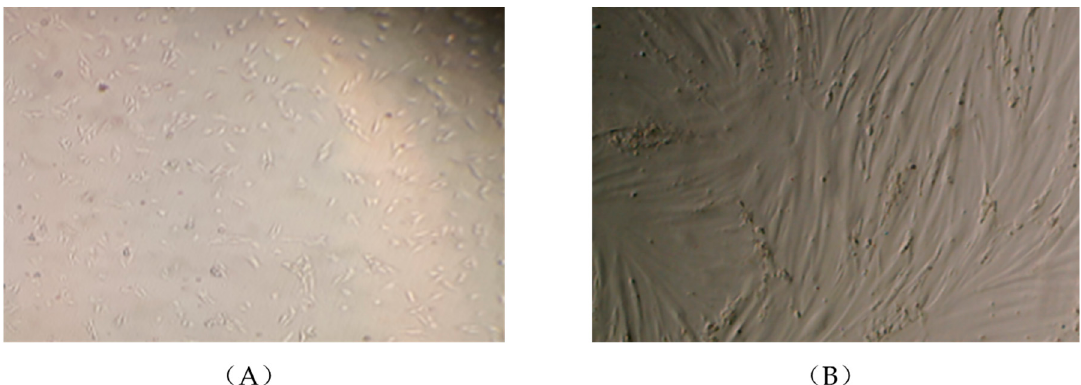
Figure 1. L6 muscle cells in the myoblast ( A ) and fully differentiated myotube ( B ) stage. L6 cells were seeded and cultured in 2% fetal bovine serum (FBS)-containing α -MEM culture media (day 1, A ) and upon reaching confluency were spontaneously differentiated into myotubes (day 7, B ). Photographs were taken using EVOS XL Core imaging system at magnification ×10 and ×20.